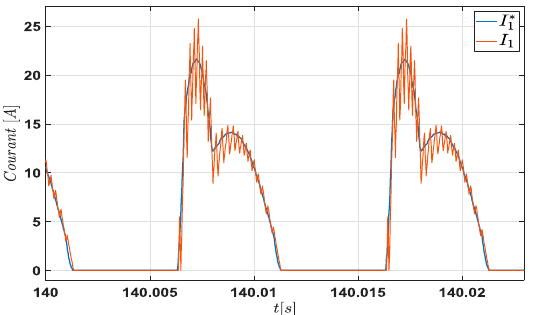
Figure 15. Current response of phase 1 using PI control.